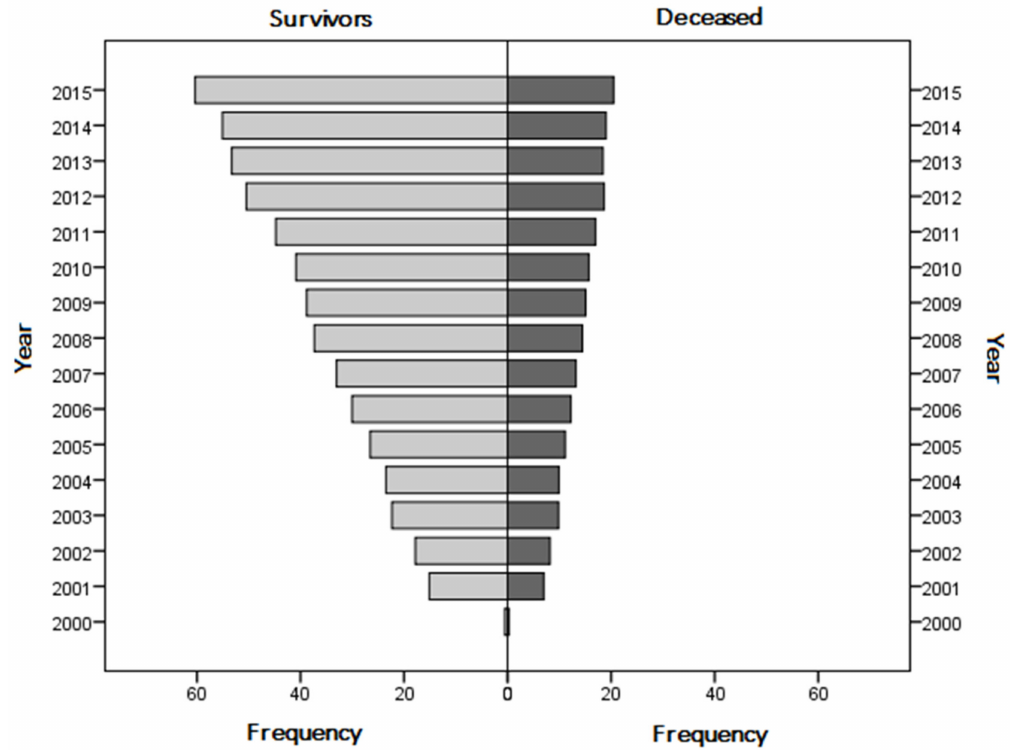
Figure 2. Prevalence of survivors and in-hospital mortality during the study period.